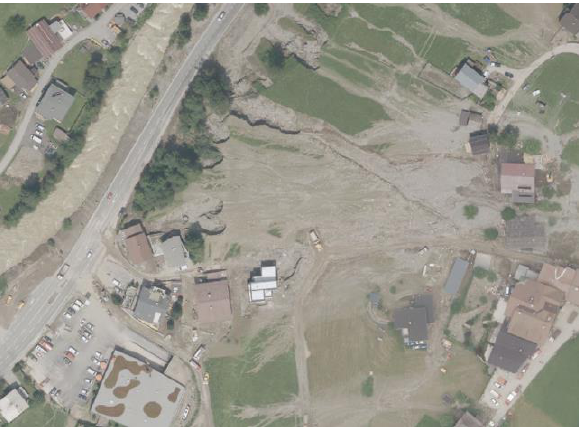
Figure 8. Ortho photo detail from See.